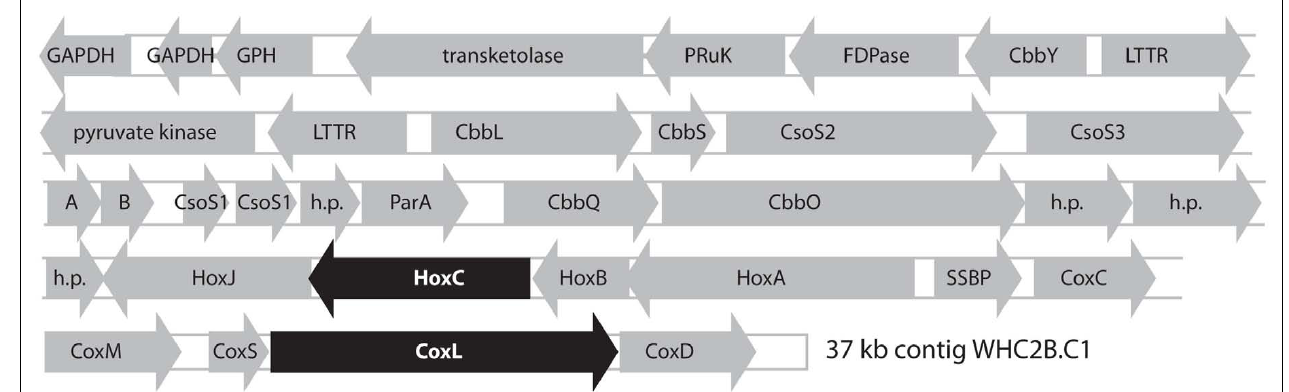
FIGURE 4 | Predicted products of open reading frames identified in the longest contig fromTablelands fluid sampleWHC2b (37kb, 67% GC, comprising 615 shotgun reads at 6.6 mean coverage). The putative large subunits of [NiFe]-hydrogenase (HoxC) and carbon monoxide dehydrogenase (CoxL) are highlighted in black to indicate that their phylogenetic relationships are shown in Figures 5 and FigureA1 in Appendix. GAPDH: NAD-dependent glyceraldehyde-3-phosphate dehydrogenase. GPH, phosphoglycolate phosphatase; PRuK, phosphoribulokinase; FDPase, type I fructose-1,6-bisphosphatase; CbbY, rubisco-associated hydrolase; LTTR, LysR-type transcriptional